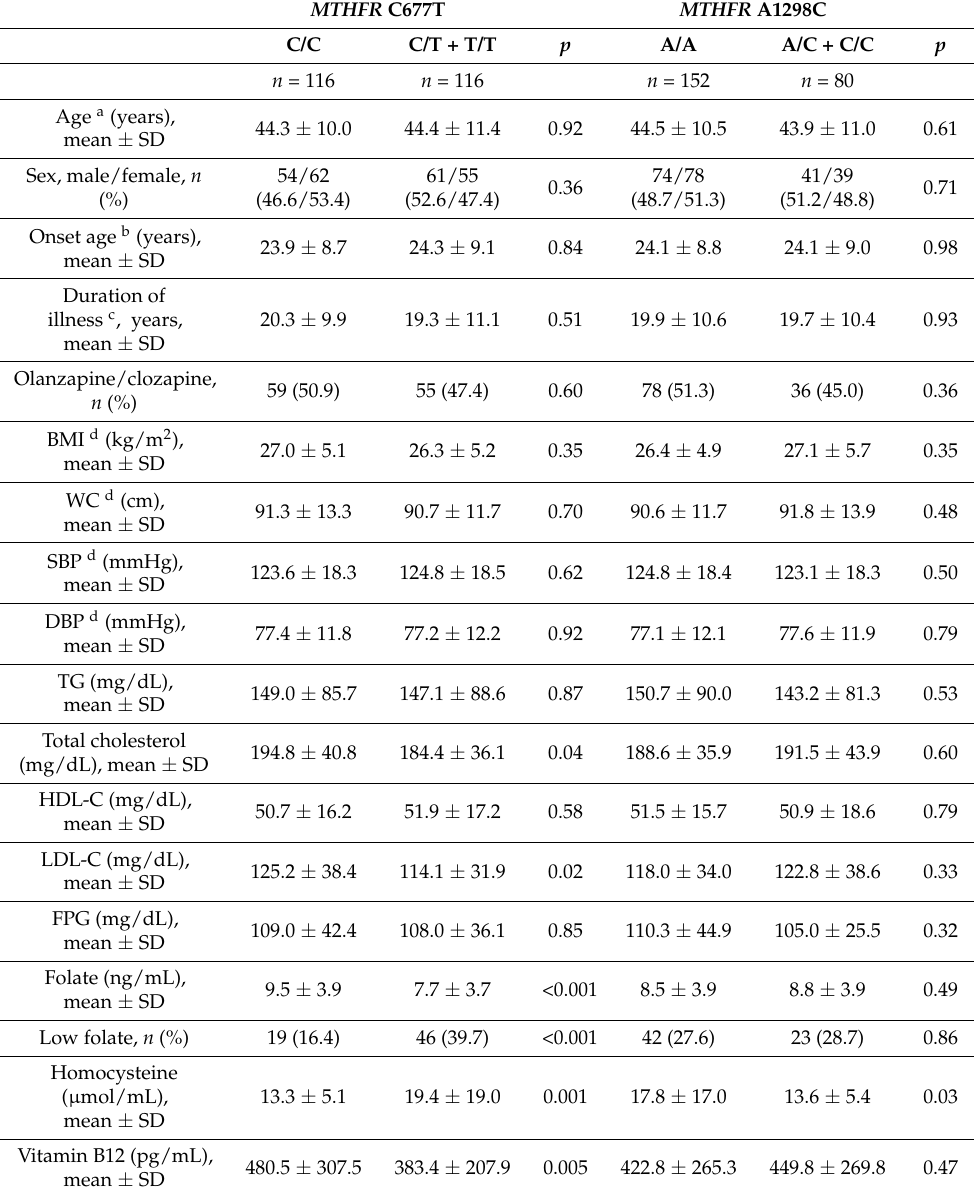
Table 2. Demographic characteristics and metabolic parameters between different genotypes of MTHFR